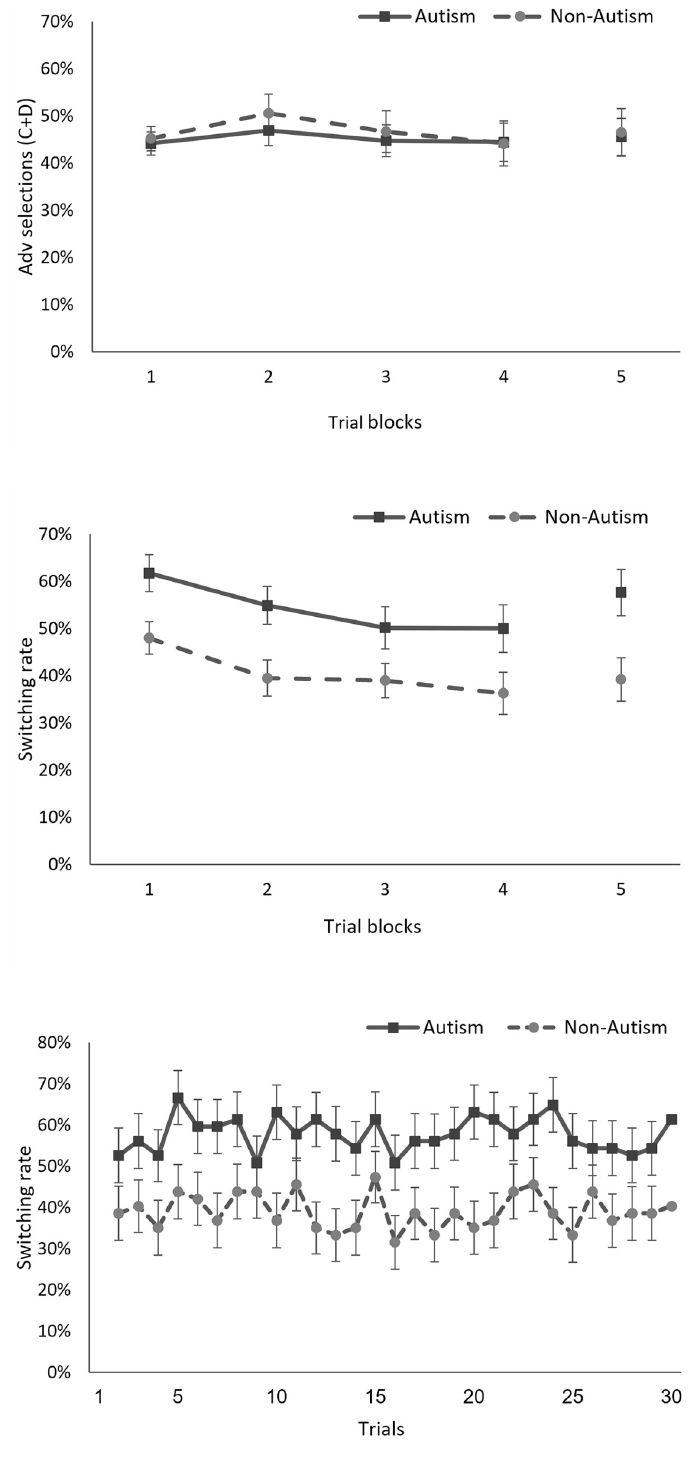
Fig 1. Results from the Iowa Gambling Task (IGT). Top panel: Percentages of advantageous selections in five trial blocks (four blocks of 30 trials in the standard IGT followed by a single no-feedback block). Middle panel: Switching rates in the five trial- blocks. Bottom panel: Switching rates during the 30 trials with no feedback. Error terms denote standard errors.